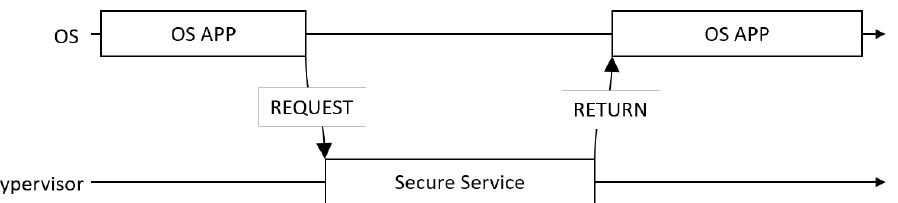
Figure 3. A time table of secure service execution—on a normal environment.